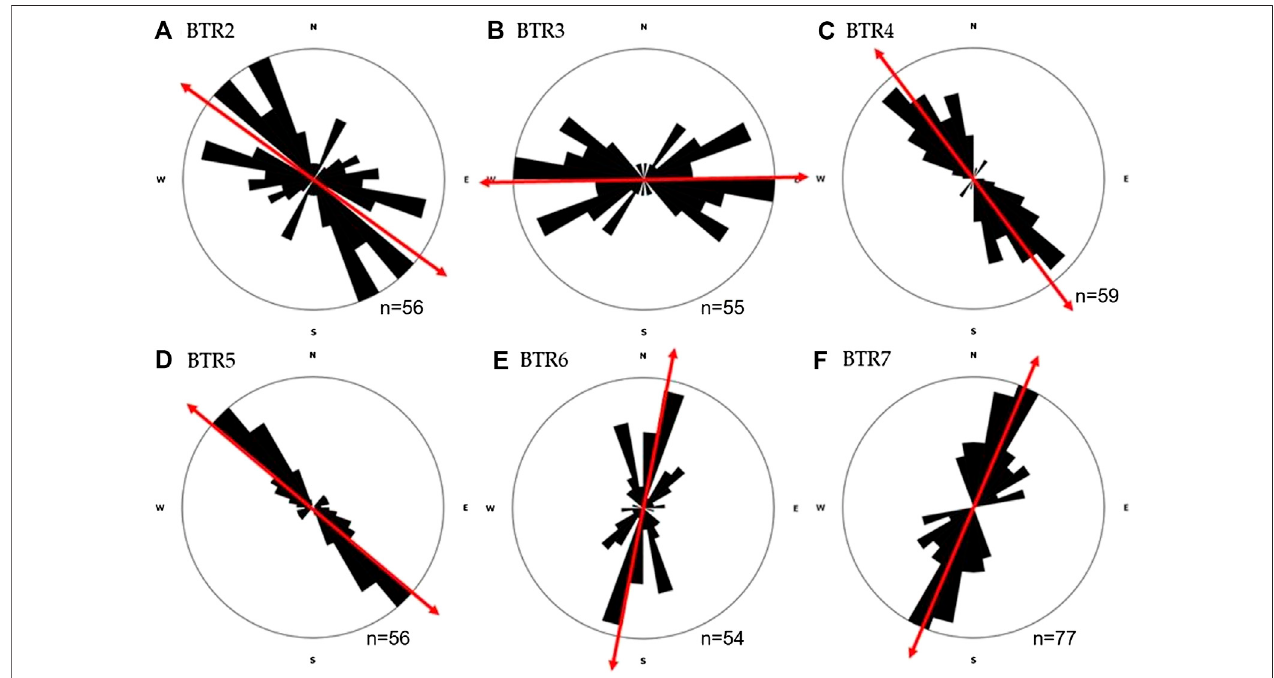
FIGURE 6 | Rose diagrams of horizontal slices of (A) BTR2; (B) BTR3; (C) BTR4; (D) BTR5; (E) BTR6; and (F) BTR7 specimens that were used in μ CT imaging. These diagrams show the distribution of the declination of pores orientation. Vertical axis represents North-South direction while horizontal axis represents East-West direction. Red arrows indicate the declination of the preferred pore orientations.